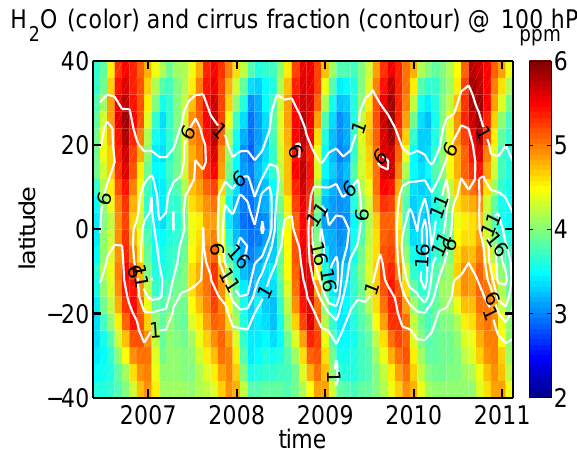
Fig. 3. Time series of zonal mean water vapor (color) and cirrus cloud fraction (contours in%) at 100hPa displayed from 40 ◦ S to 40 ◦ N. Poleward transport of high and low H 2 O out of the tropics can be identified along lines of similar color. Lower H 2 O in 2008 and 2009 is due to ENSO-La Ni˜na and QBO being in phase. Max- imum cloud fraction occurs at the same period as minimum water